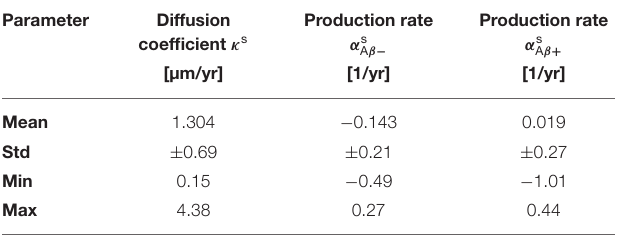
TABLE 2 | Posterior distributions.